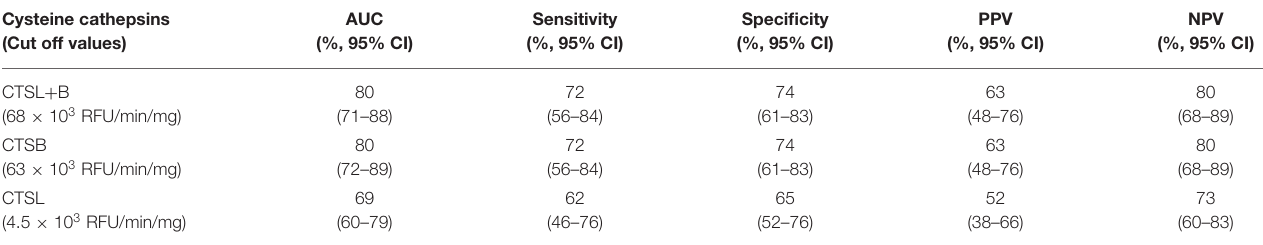
TABLE 2 | Diagnostic performance assessment for cysteine cathepsins in GBC